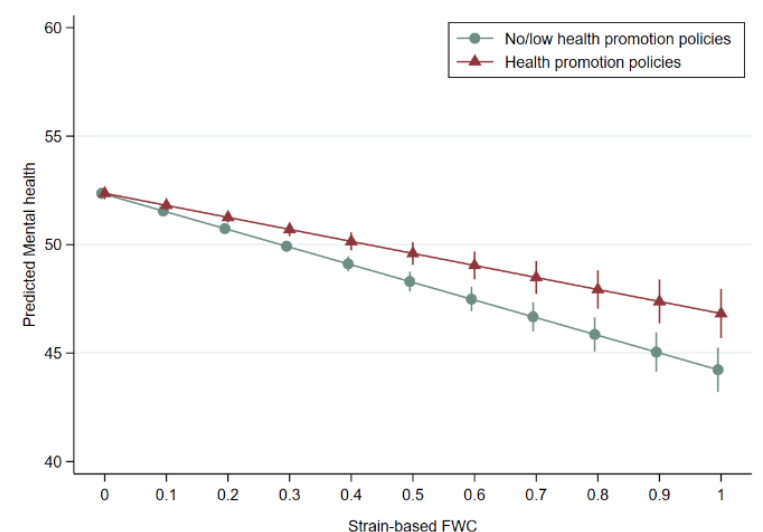
Interaction plots for strain-based FWC#health-promotion